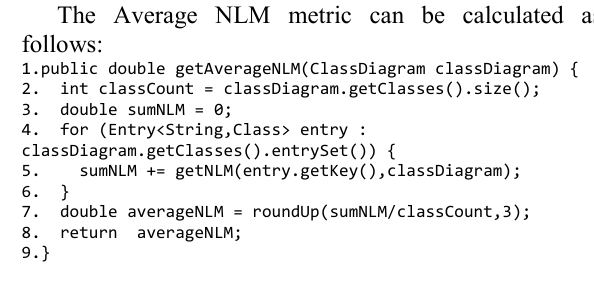
Fig. 7. Performance of the Average DAC Metric Calculation